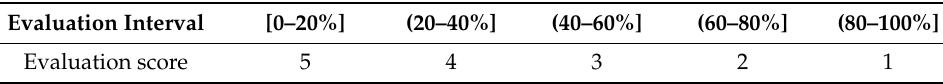
Table 5. Evaluation index scale table. Evaluation